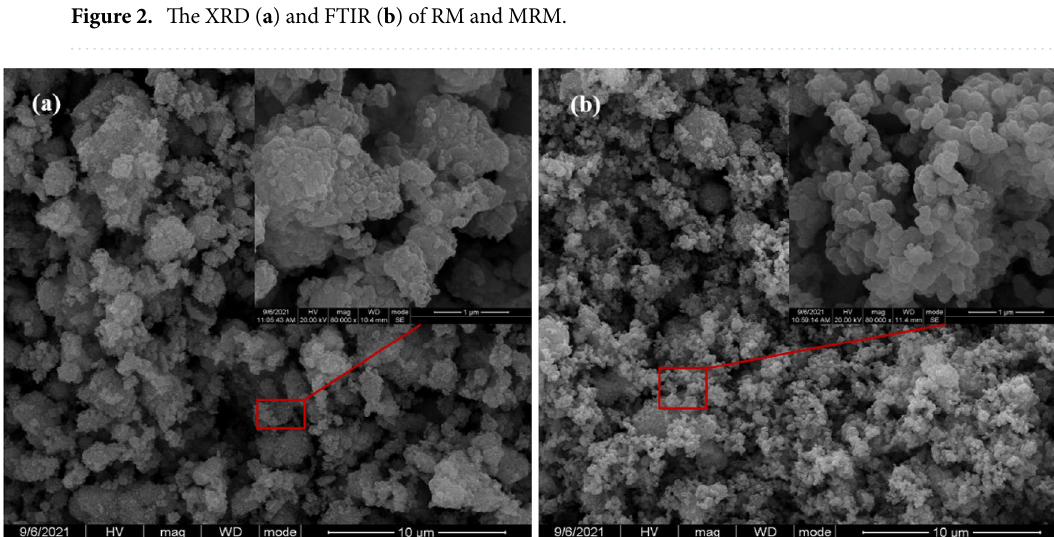
Figure 3. The SEM micrographs of RM ( a ) and MRM ( b ) at different